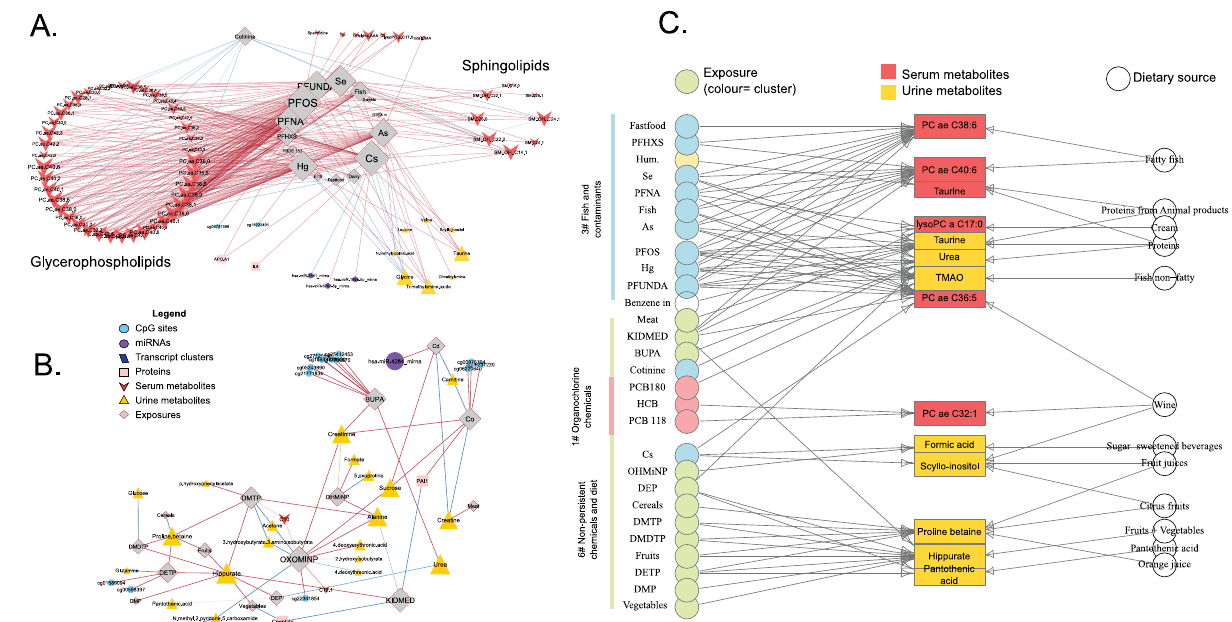
Fig. 7 | Metabolite signatures of the childhood exposome and dietary sources. A Cluster childhood#3 includes the signi fi cant associations between fi sh and sev- eral contaminants (As, Hg, PFOS) and serum metabolites (mainly glyceropho- spholipids). B Cluster childhood#6 includes the signi fi cant associations between diet (vegetables, fruit, cereals) and organophosphate (OP) pesticides with urinary metabolites. For A , B , nodes of the network are depicted with a different colour/ shape depending if they are exposures or features of a particular molecular layer (see legend in the fi gure). An exposure and a molecular feature were connected